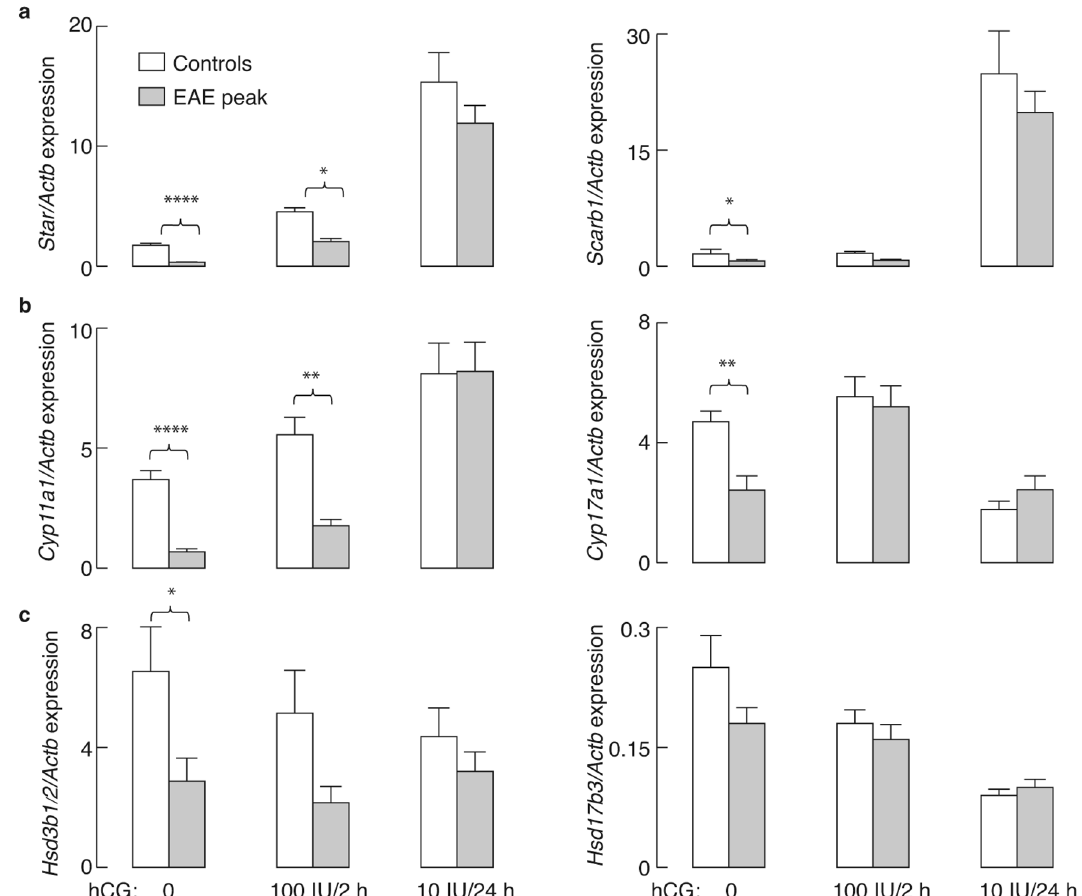
Figure 6. Expression of steroidogenic genes in testicular interstitial cells in control and peak EAE groups of saline- and hCG-treated rats. Control and peak EAE rats were treated with a subcutaneous injection of saline, 100 IU hCG for 2 h, or 10 IU hCG for 24 h. qRT-PCR analysis of rat interstitial cells: ( a ) Star (left) and Scarb1 (right) ; ( b ) Cyp11a1 (left) and Cyp17a1 (right); ( c ) Hsd3b1/2 (left) and Hsd17b3 (right). The results are presented as mean ± SEM (n = 6 animals/group). The presented statistical significance was determined by Mann– Whitney test for control and peak EAE groups in each treatment. The results are presented as mean ± SEM. * P < 0.05, ** P < 0.01, *** P < 0.001, **** P < 0.0001. The figure was made using KaleidaGraph (version 4.1.0; http:// www. syner gy. com) and Illustrator (version 25.1.0; http:// www. adobe.